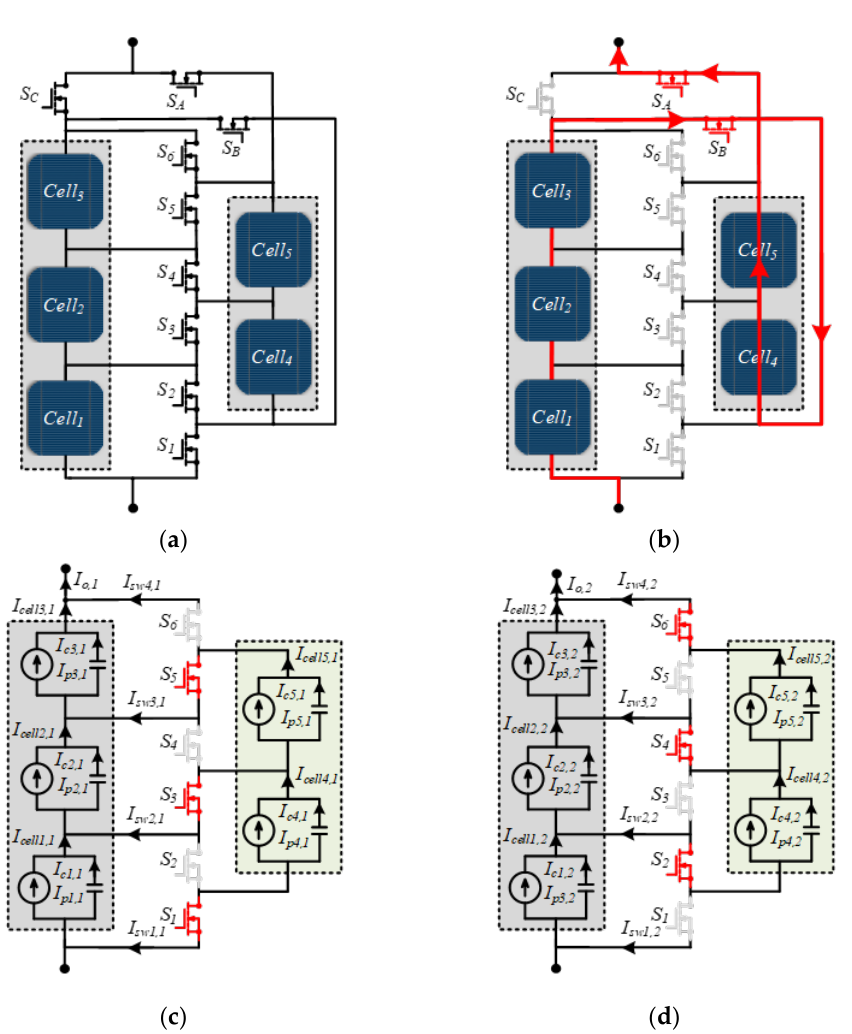
Figure 7. A photovoltaic (PV) system with five series-connected PV cells: ( a ) general schematic; ( b ) Mode 1; ( c ) Mode 2; ( d ) Mode 3.